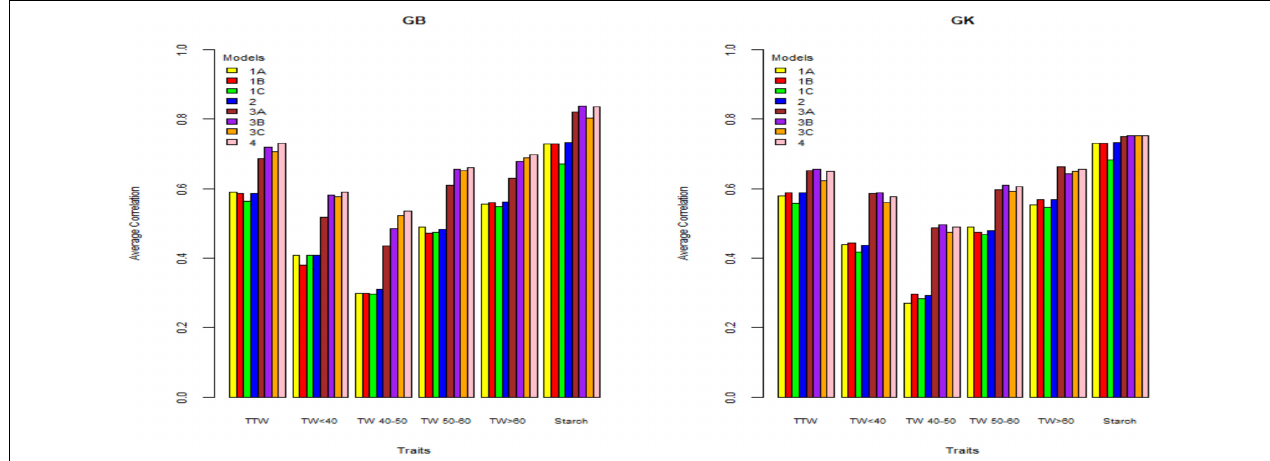
FIGURE 2 | Genome-based predictions (average correlation between observed and predicted values) of potato cultivars in Mosslunda site for total tuber weight (TTW), tuber weight with size below 40 mm (TW < 40), tuber weight with 40–50 mm (TW 40–50), tuber weight with 50–60 mm size (TW 50–60), tuber weight above 60 mm size (TW > 60), and tuber starch percentage (Starch) considering single environment pseudo-diploid (A) (model 1) (1A), additive tetrasomic polyploid (B) (model 1) (1B), full tetraploid (C) (model 1) (1C), and B-C (model 2) (2) and multi-environment pseudo-diploid (A) (model 3) (3A), additive tetrasomic polyploid (B)